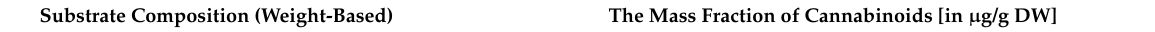
Table 1. The feed composition and the cannabinoids mass fraction [ µ g/g DW] in the different treatments of the black soldier fly larvae